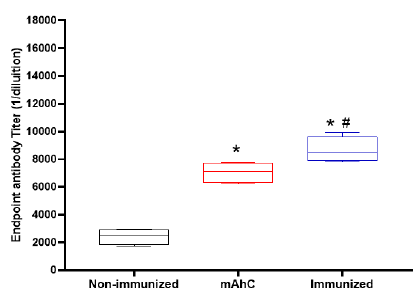
Figure 5. Stimulation of the humoral response of inactivated A. baumannii whole-cell vaccine adsorbed on mAhC in CY-treated mice. Data refer to the levels of total IgG produced before the application of a lethal dose of A. baumannii (4.0 × 10 8 CFU/mL) in immunized CY-treated mice, non-immunized CY-treated mice, and CY-treated mice inoculated with mAhC using 6 animals per group. (*) p < 0.05 represents a comparative analysis between non-immunized CY-treated mice vs. CY-treated mice inoculated with mAhC using 6 animals per group. (*#) p < 0.05 represents a comparative analysis between immunized CY-treated mice vs. CY-treated mice inoculated with mAhC.